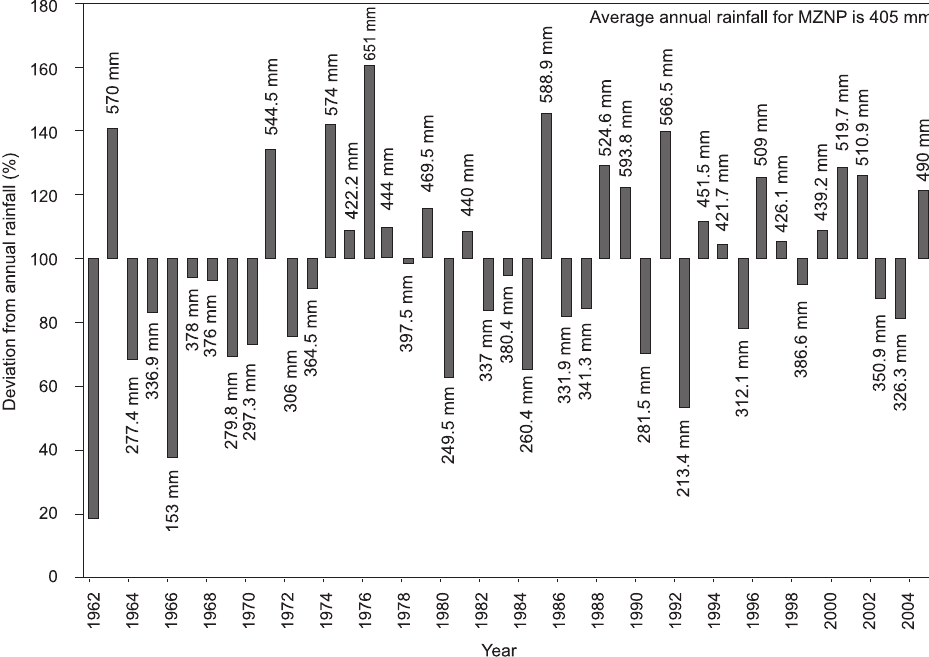
Fig. 2. Percentage deviation from average annual rainfall at Mountain Zebra National Park between 1962 and 2004. (Rainfall year = Jan. to